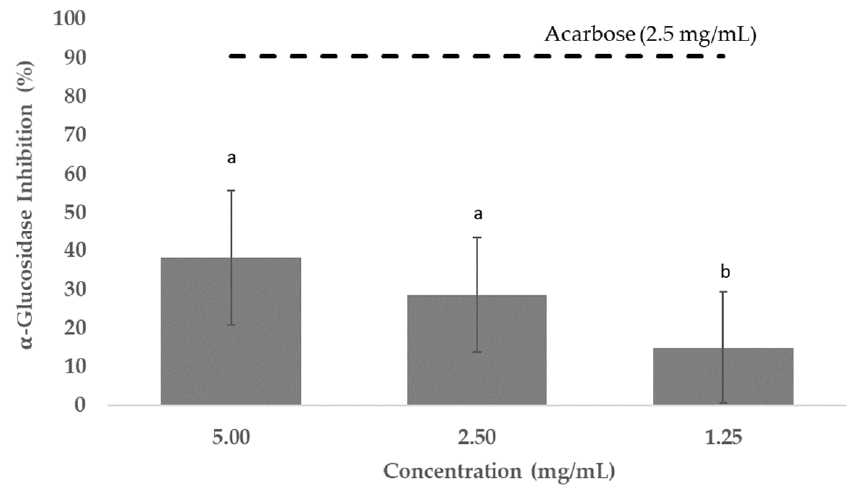
ited (means ± SD) tive control. a,b ters mean that Figure 4. Percentage of α -glucosidase activity inhibited (means ± SD) tested with sugarcane straw extract. Acarbose (2.5 mg/mL) was used as positive control. a,b Different letters mean that statistically differences were obtained ( p < 0.05). significant differences were obtained ( p <